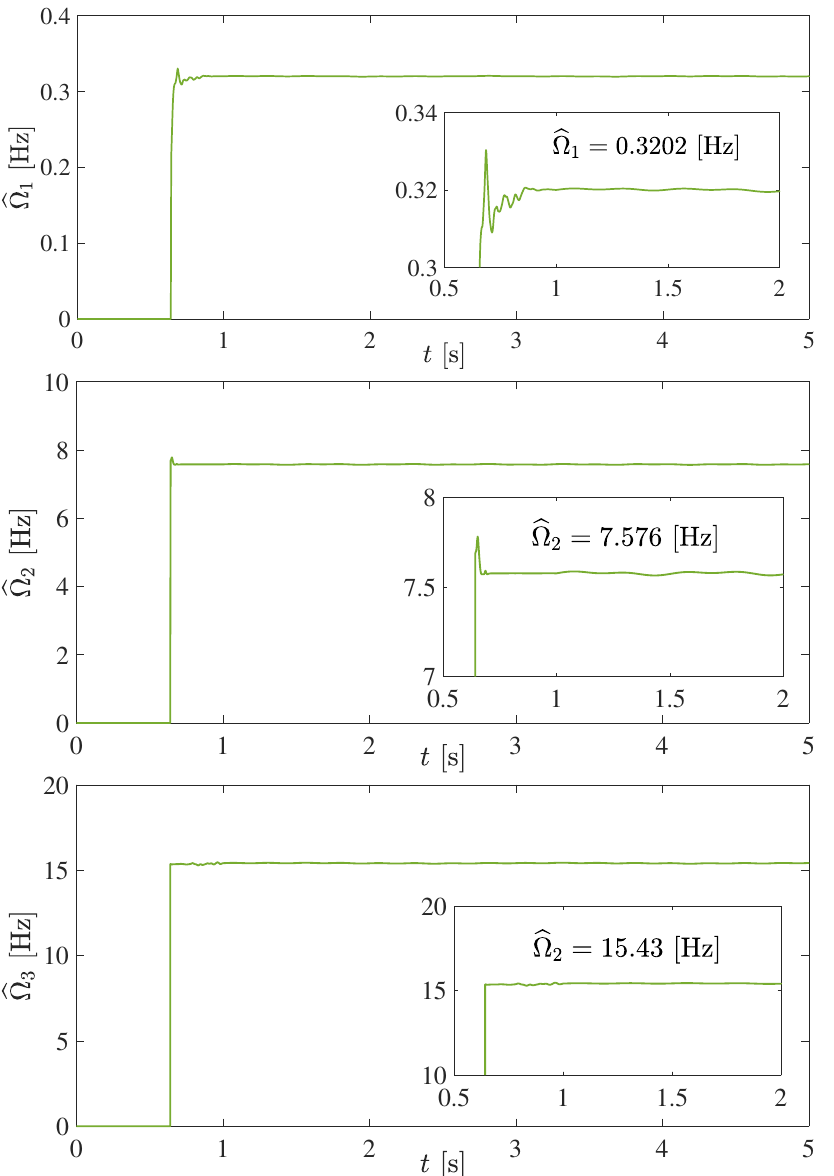
Figure 7. Online algebraic estimation of exogenous excitation frequencies of the distributed- parameter